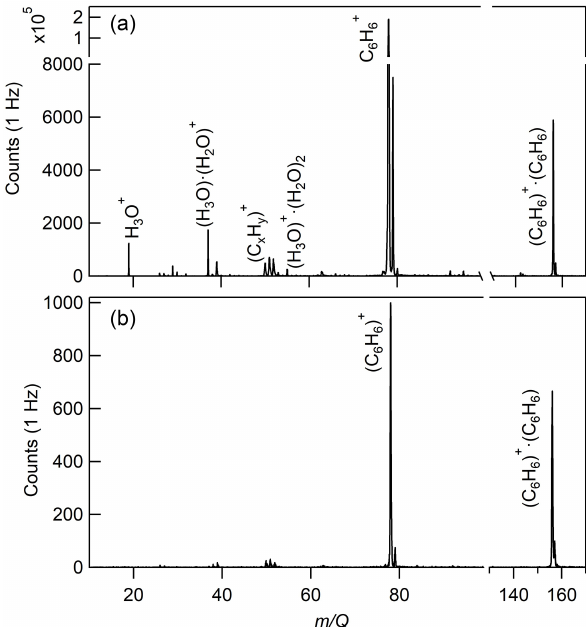
Figure 4. (a) CI-ToFMS mass spectrum acquired when overflowing the inlet with nominally dry zero air for a benzene neutral concen- tration of 300ppm using a liquid reagent ion delivery and (b) same as in (a) , but with the first RF-only octupole ion guide turned off, resulting in a much weaker electric field strength.